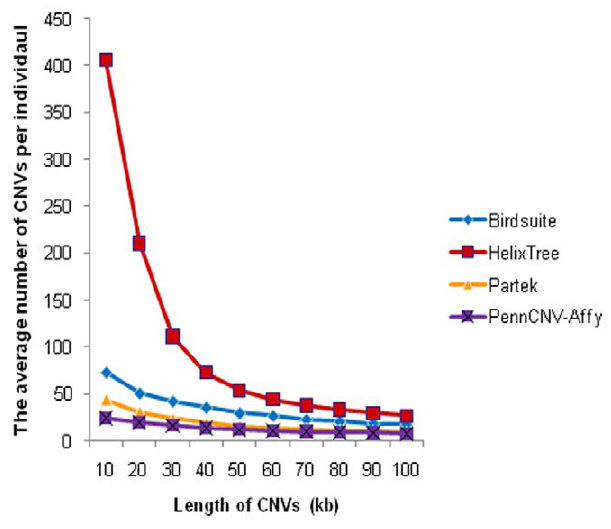
Figure 1. The average number of CNVs per individual called by each of the four CNV-calling programs. The average number of CNVs per individual varies greatly among programs, especially for CNVs less than 10 kb. The X axis represents length of CNVs. The Y axis is the